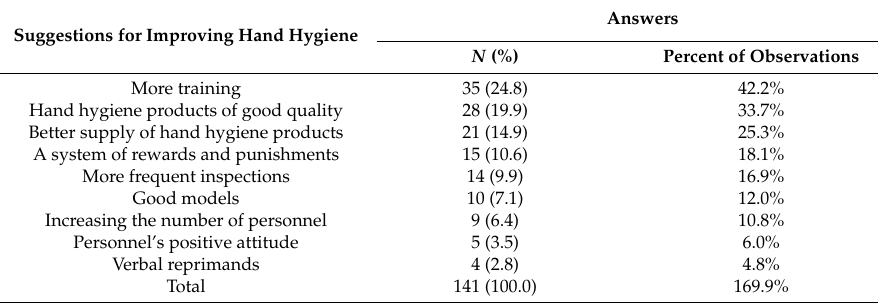
Table 6. Answers to the multiple choice question: What would encourage medical personnel to obey HH rules better? Number of respondents: 79, no answer: